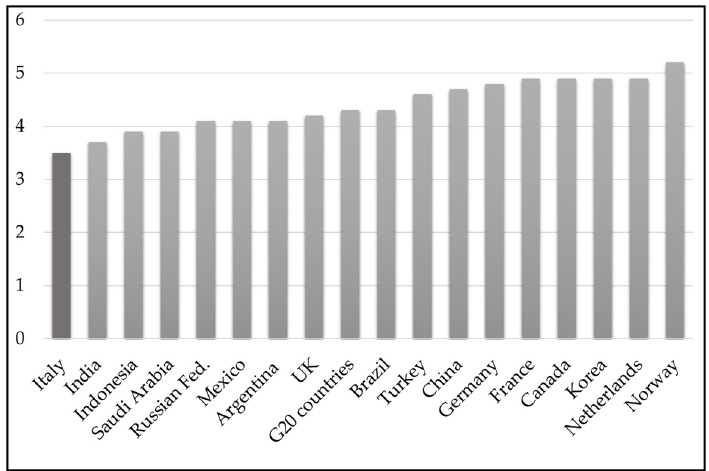
Figure 1. Financial knowledge in Italy compared to G20 countries (averages; weighted data). Source: OECD (2017) .